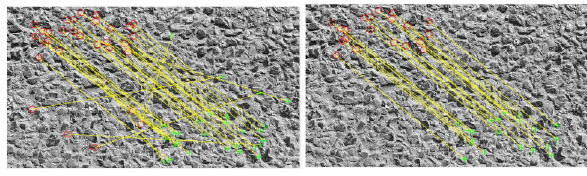
Figure 5 RANSAC to eliminate mismatched points